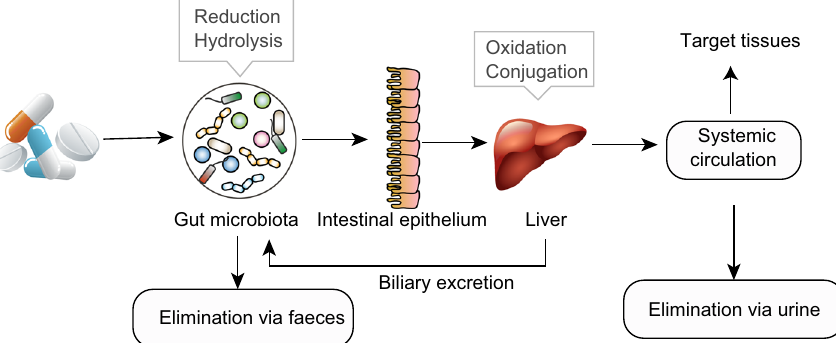
Figure 1. Sites and types of reactions for drug metabolism. Bacterial enzymes can participate in drug metabolism mainly through reductive and hydrolytic reactions. Drugs and their metabolites can be absorbed from the intestine and transported via the portal vein to the liver, where a fraction of them will be taken up and another fraction will spill over to the systemic circulation. Hepatic enzymes mainly conduct oxidative and conjugative reactions. Subsequently, drugs and/or their metabolites can be excreted back into the blood to be transported to targeted tissues, removed by the kidney via the urine, or directly excreted by the liver via the biliary system back into the gut lumen.